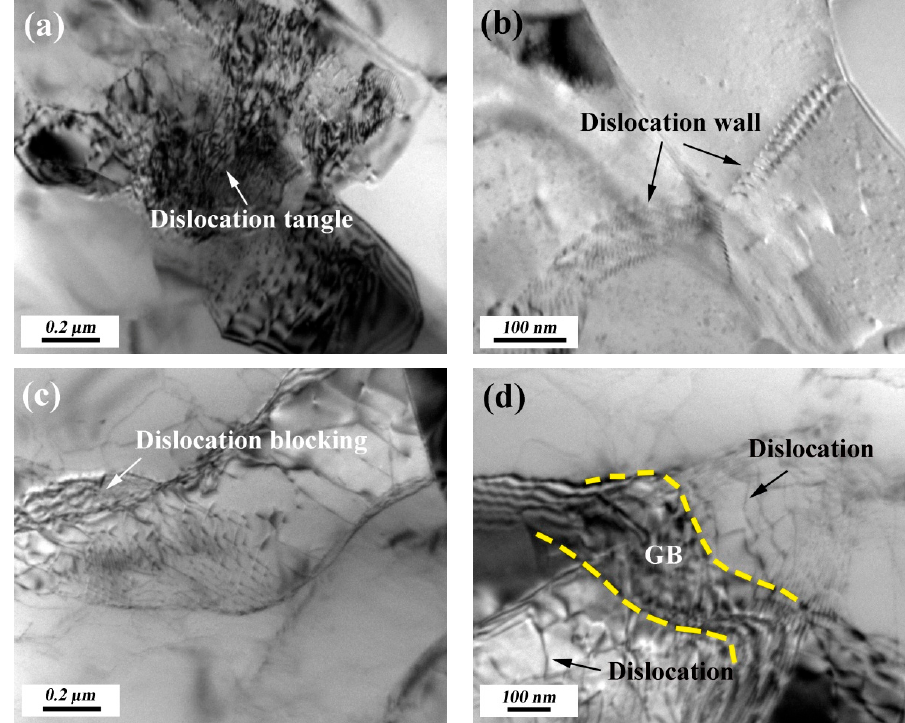
Figure 3. Bright field TEM images of dislocation configuration in 10 16 ions·cm − 2 irradiated sample: ( a ) dislocation tangle; ( b ) dislocation wall; ( c ) dislocation blocking; and ( d ) dislocation pass through GB.